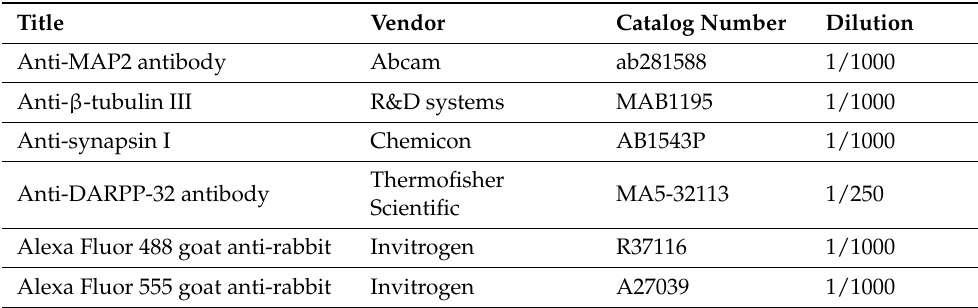
Table 1. List of the antibodies used for